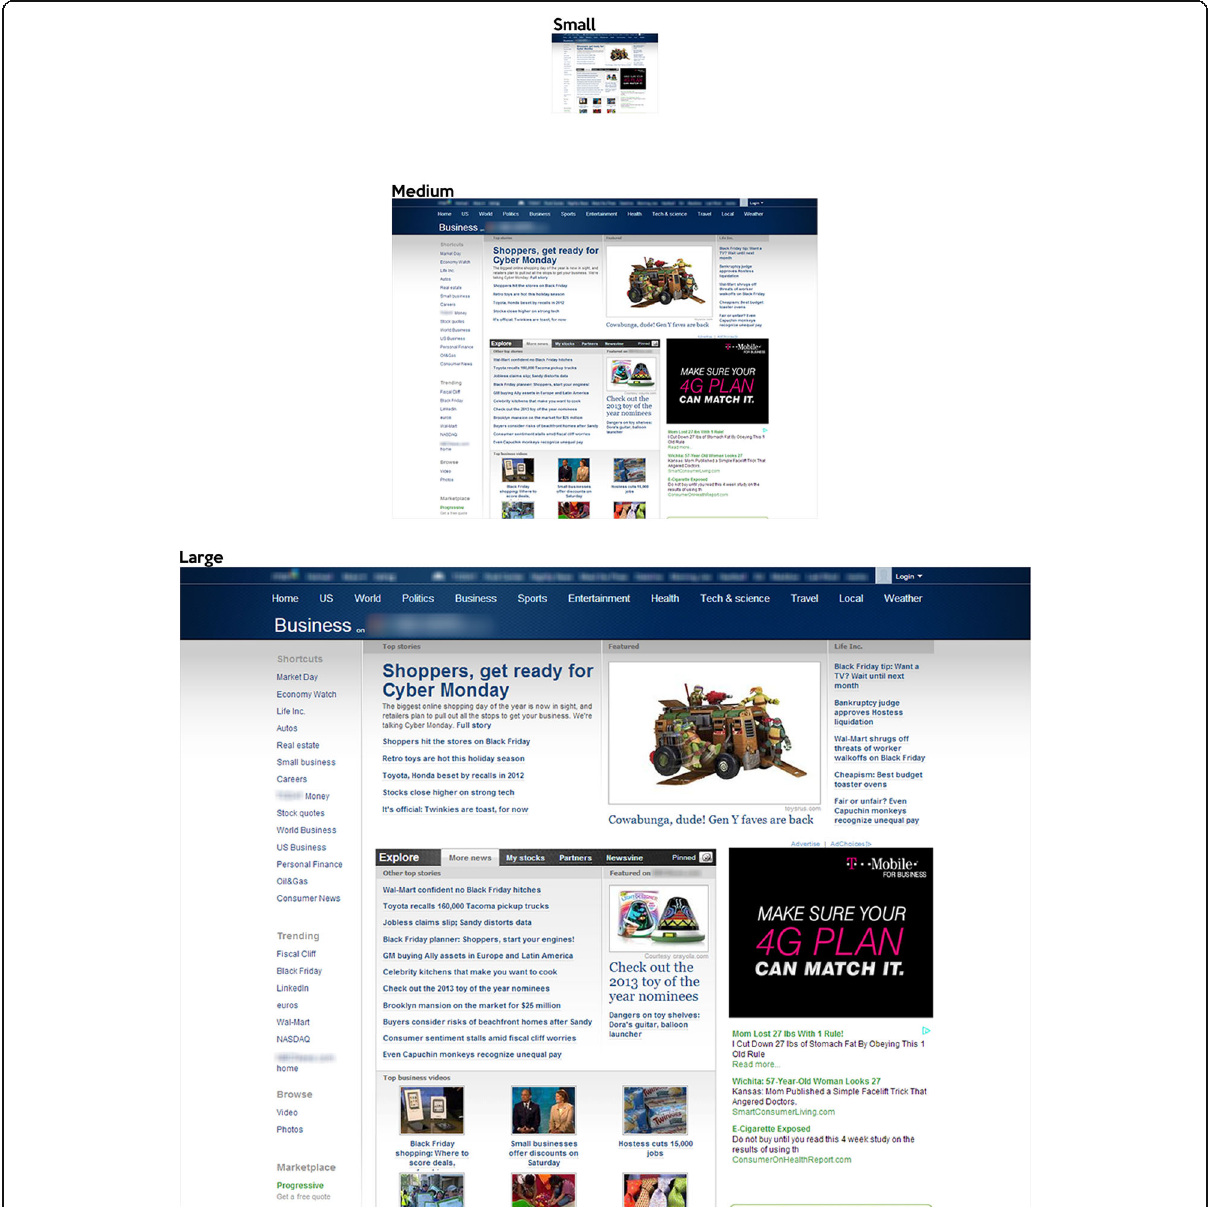
Fig. 7 Relative size comparisons of the stimuli from Experiment